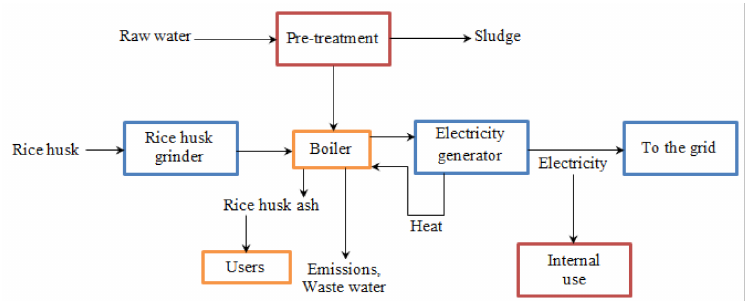
Figure 13. Process diagram for RiH-fueled power generation using a combustion